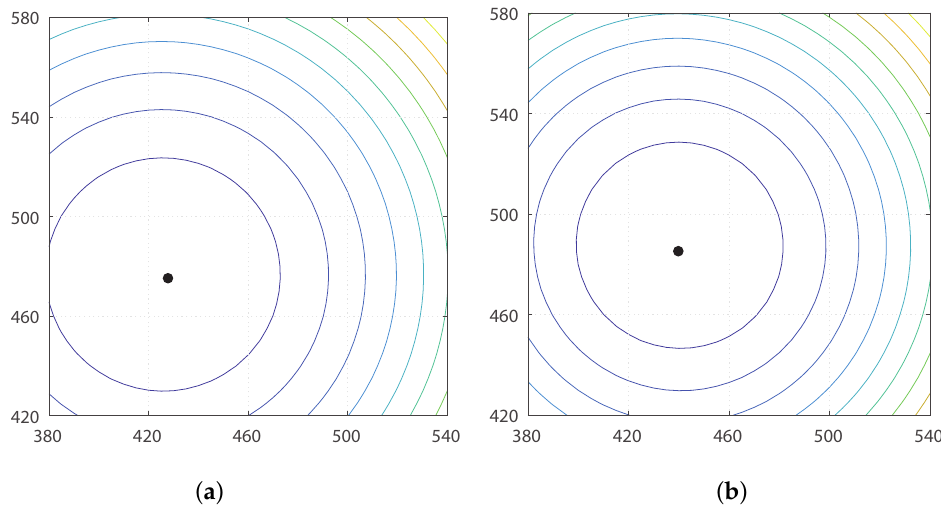
Figure 7. Contour plots at two different positions in the indoor environment env 0 (Figure 3). ( a ) Contour of moment potential at (460,460); ( b ) contour of moment potential at home position (500,500); black dots indicate the minimum potential